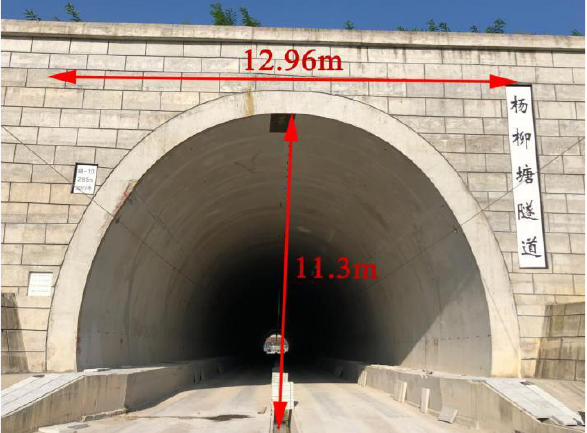
Figure 1. Current status of the Yangliutang (YLT) Tunnel.